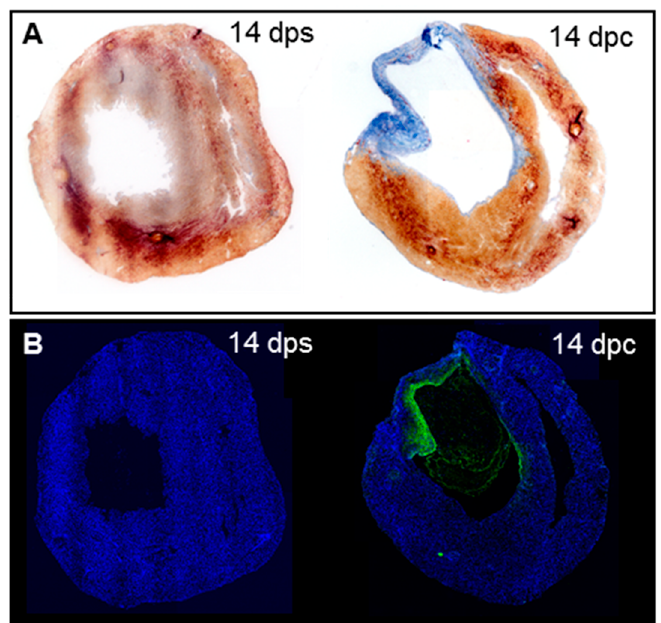
Figure 4. Collagenolytic activity in the scar of neonatal mouse hearts after cryoinjury. ( A ) AFOG staining on neonatal mouse hearts at 14 dps ( n = 3) and 14 dpc ( n = 4). ( B ) In situ zymography on consecutive sections from hearts in (A).